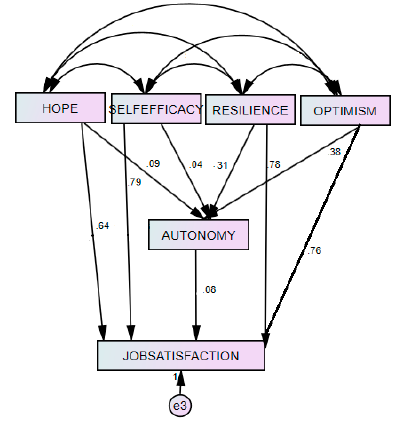
Figure 1. Structural path analysis. Table 12. Regression weights.